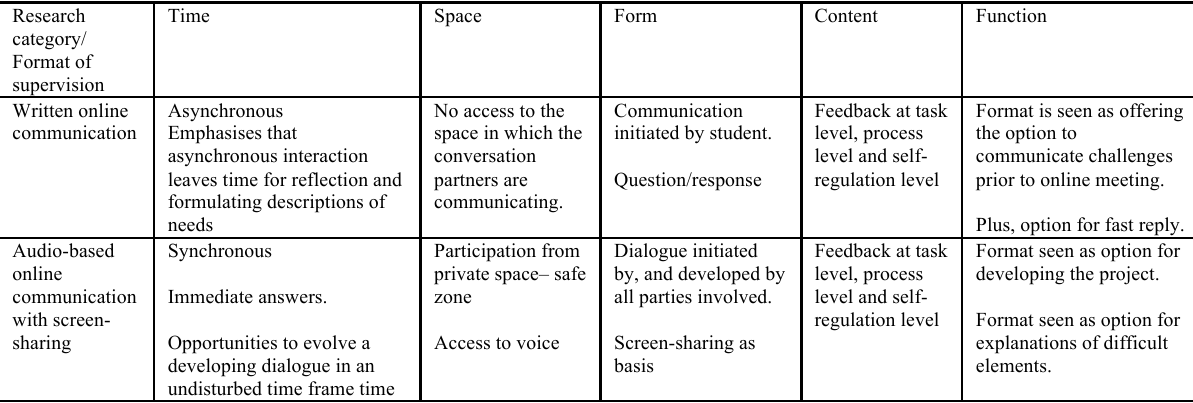
Table 9: Findings concerning Sofia’s experience of various online